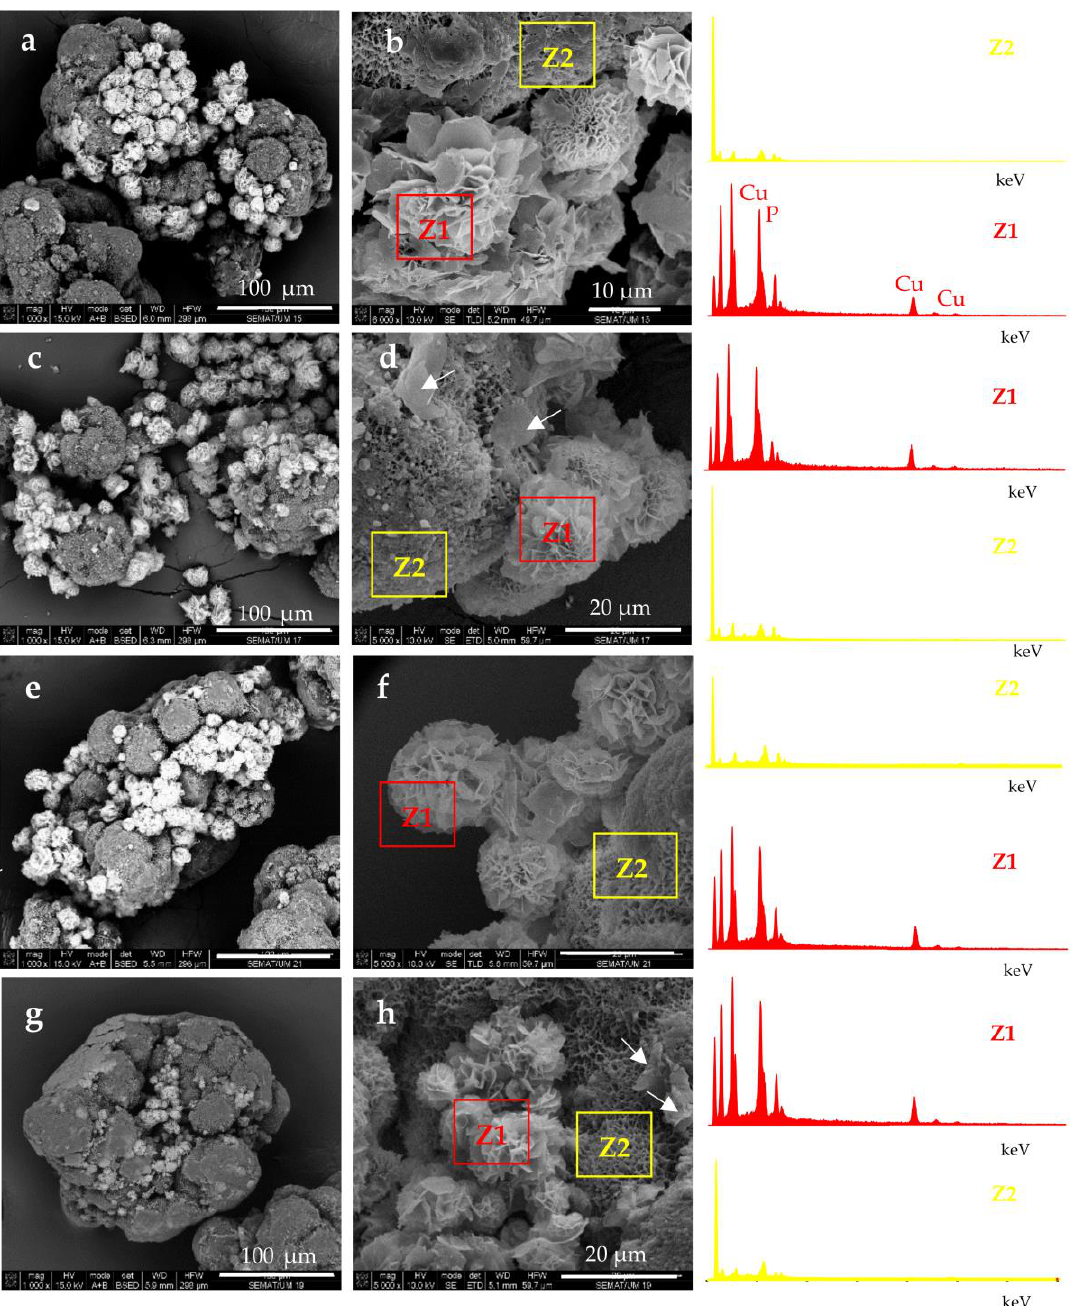
Figure 3. SEM micrographs of polymer-assisted hybrid nanoflowers (PANF): ( a , b ) NF GH/PA; ( c , d ) NF GH&PA; ( e , f ) NF G/PAiH; ( g , h ) NG G&PAiH. For sample designation see Figure 1.